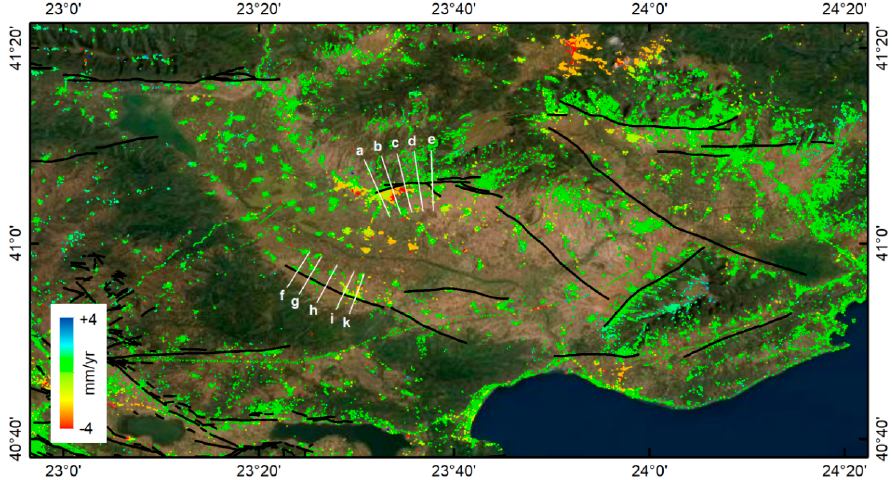
Figure 8. Average LoS displacement rates for the period 2015–2020, derived by SNAPPING service on GEP using Sentinel-1 data from ascending track 102. White lines (a–e and f–k) correspond to spatial profiles shown in Figure 8. Please note that, for the selected color scale, rates higher than ±4 mm/yr appear saturated to allow for the proper visualization of spatial variability of motion.